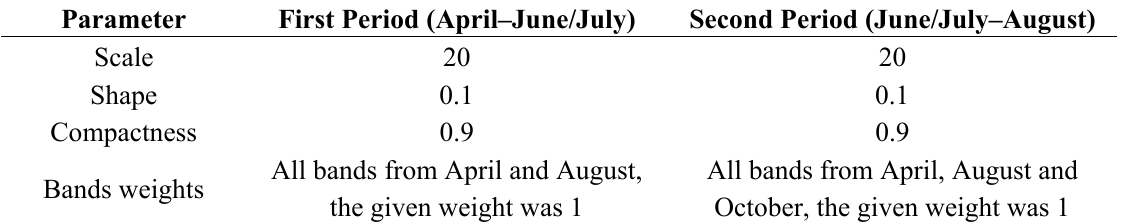
Table 1. Multi-resolution segmentation parameters used in